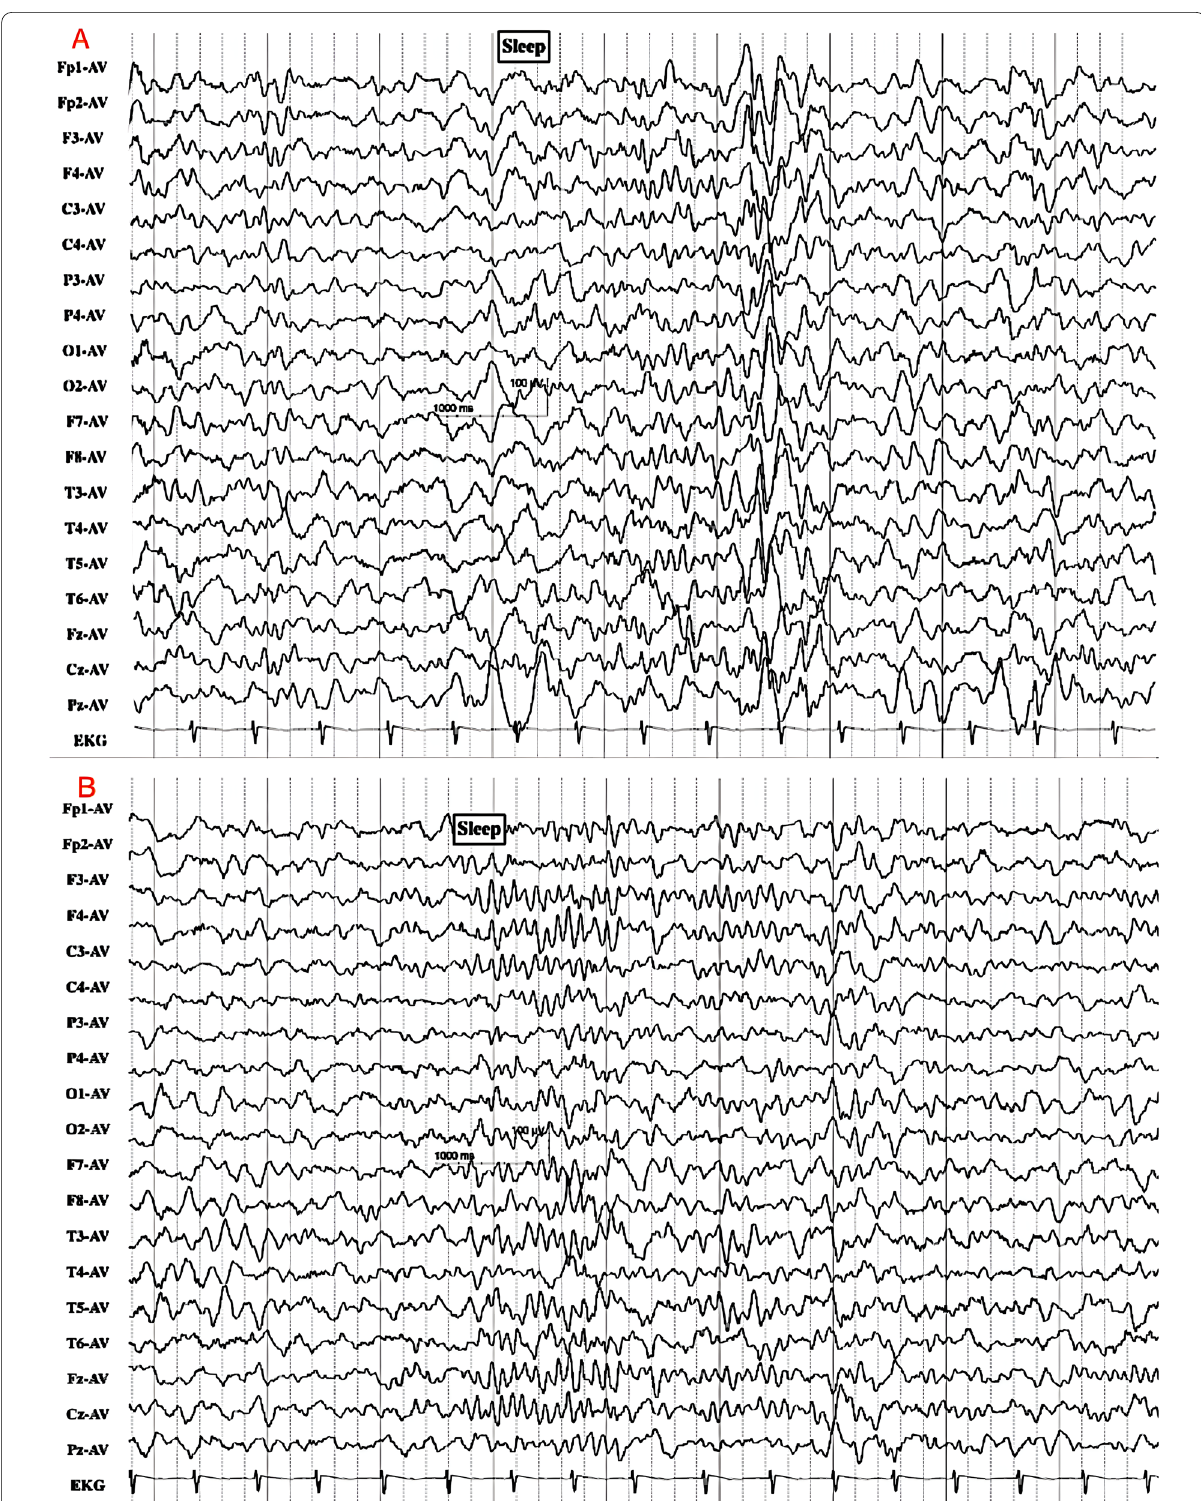
Fig. 3 EEG at age 1 year and 3 months (on March 19, 2020). After almost 8 months of TPM treatment, EEG showed low-amplitude fast waves when he was awake or